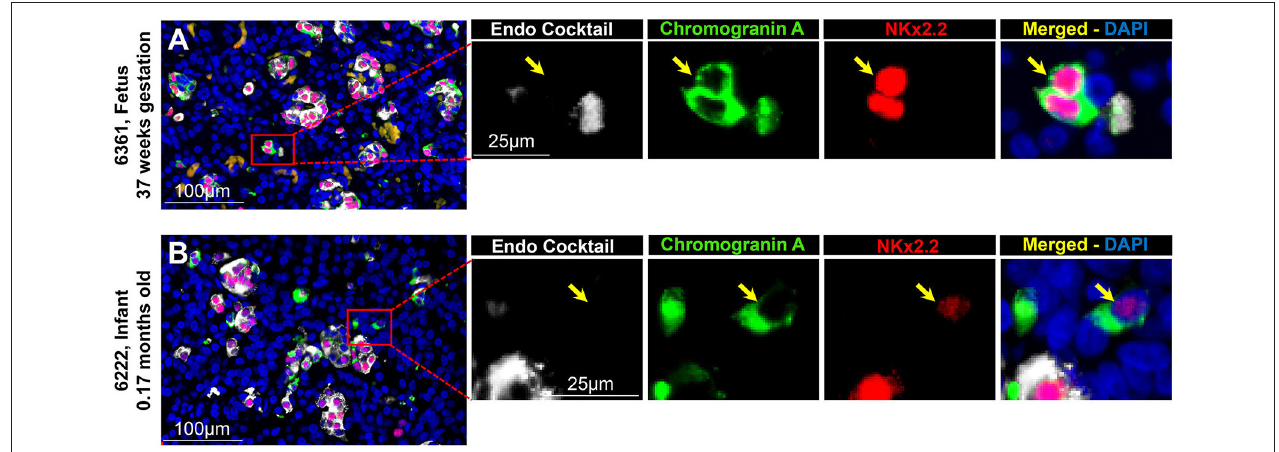
FIGURE 4 | ChromograninA positive hormone-negative (CPHN) cells express the beta-cell differentiation transcription factor NKX2.2 in both fetuses and infants. Representative pancreatic sections from fetal (A) and infant (B) donors immunostained for Endocrine cocktail (insulin, glucagon, somatostatin, pancreatic polypeptide, and ghrelin) (white), chromograninA (green), the transcription factor NKX2.2 (red) and DAPI (blue). Yellow arrows indicate CPHN cells. Scale bars: 100 µ m for low power and 25 µ m for high magnification